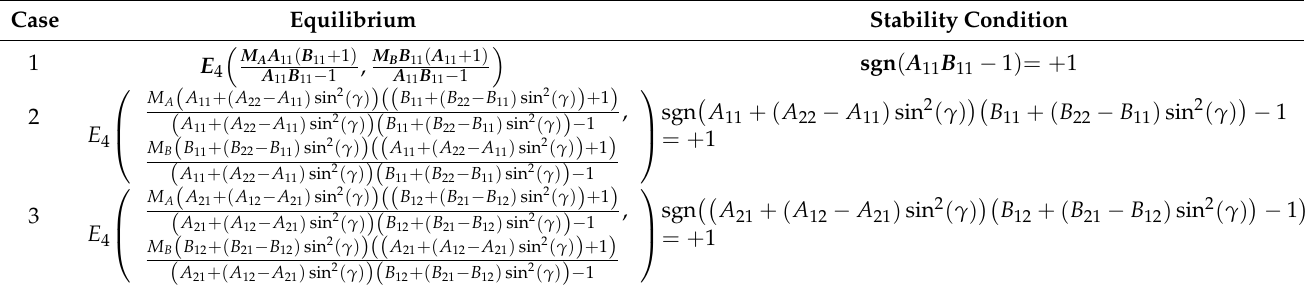
Table 6. Stability conditions for coexistence equilibrium by case for cooperation symbiosis. Case Equilibrium Stability